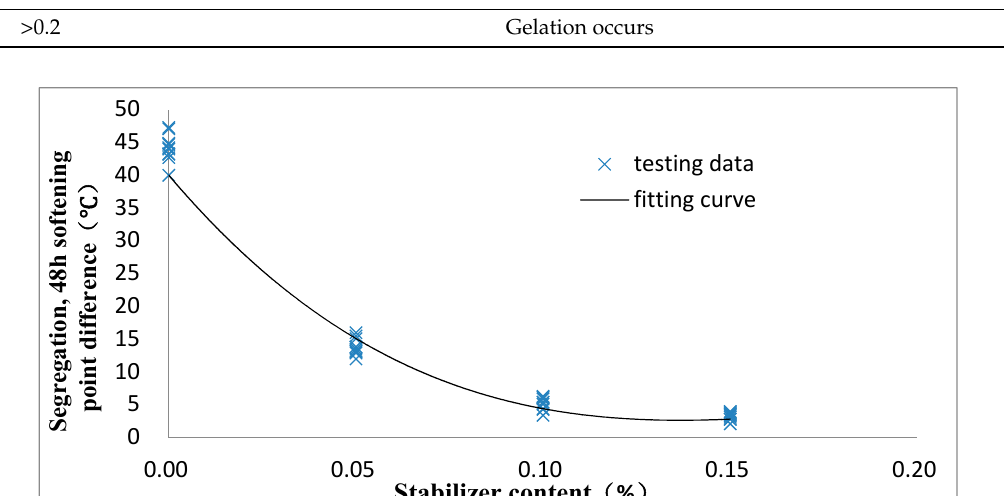
Figure 8. The relationship between stabilizer content and the 48-h segregation softening point difference of SBS-modified bitumen.